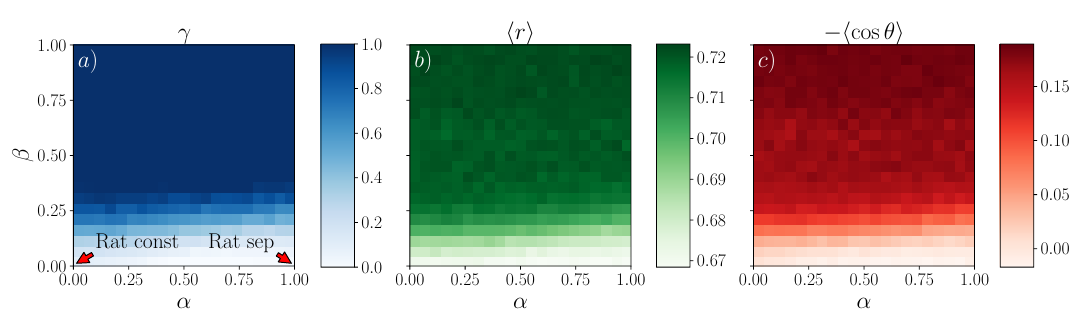
Figure 2: Characterizations of the integrable to chaotic transition using the γ 19 parameter (a) and the 〈 r 〉 (b) and −〈 cos θ 〉 (c) averages of the complex spacing ratios 20. Each point represents a sample of 20 Liouvillians of matrix dimension